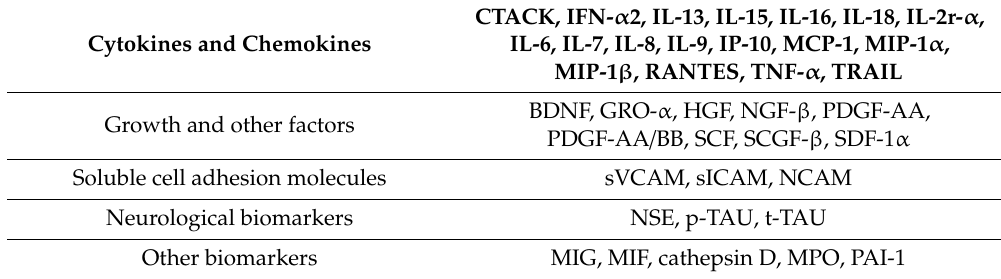
Table 2. List of analytes included in the correlation